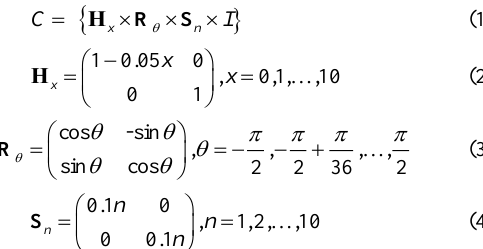
Figure 2. Flowchart of the proposed target extraction algorithm